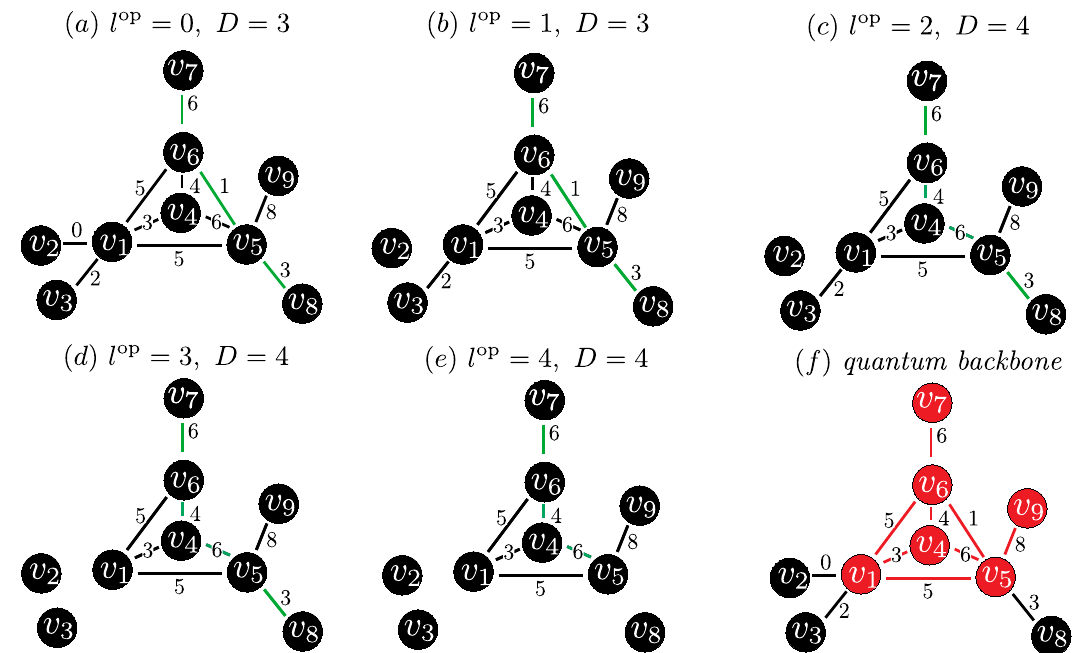
Fig. 2 Quantum network backbone. Illustration of how the quantum backbone can be computed where the numbers written in each link represents the number of entangled pairs contained in it. We begin in a with a D = 3 network and the operational distance l op = 0 meaning none of the links in the network need to be removed. As the operational distance l op is increased from 1b to 2 c we see that we have removed links with n ij < 2. Further in c we notice that the distance of the network increases from D = 3 to D = 4 due to the v 5 – v 6 link being removed in b due to lack of resources. Then in d, e we continue to remove various links until we reach an operational distance that is largest than the diameter of the network. We are now left in e where the largest connected network component, termed our quantum backbone. Finally in f we superimpose this quantum backbone (shown in red) onto the entire network. The size of the backbone (number of nodes in the largest connected component of the backbone) is the number of red nodes nodes in f , namely